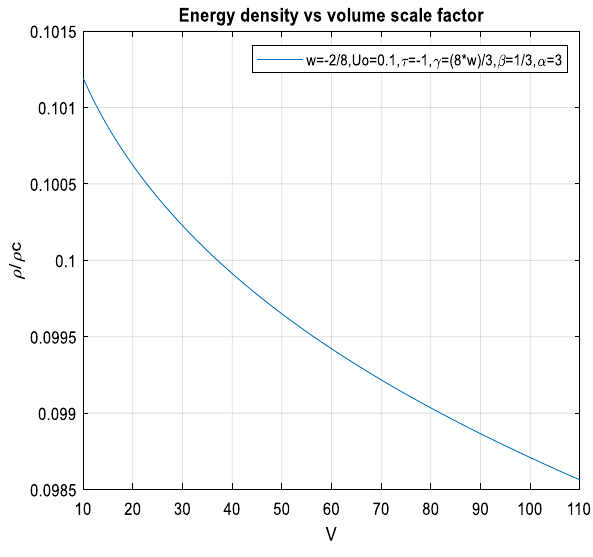
; U = 0 . 1 ; τ = − 1 ; γ = 0 8